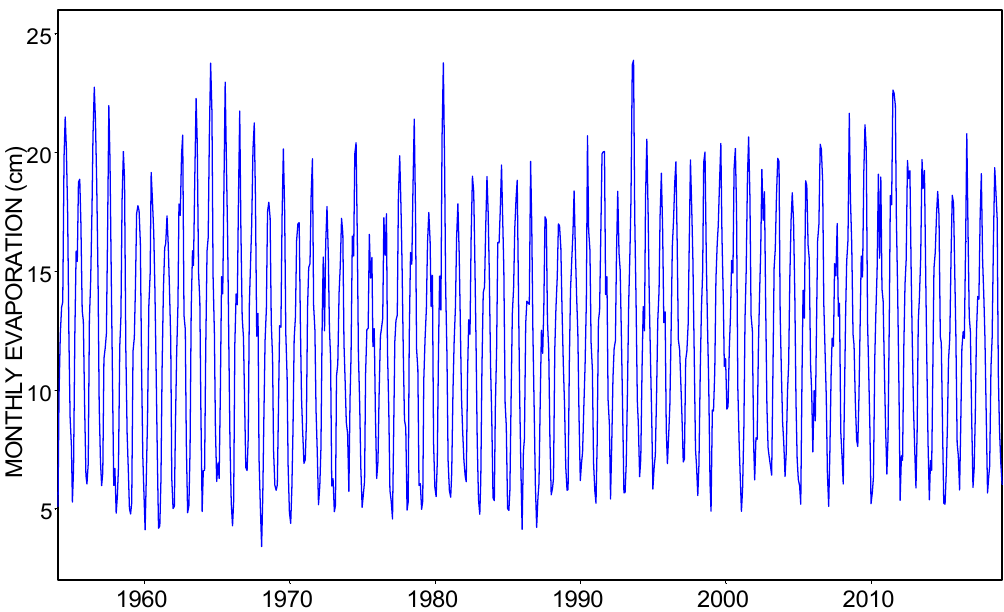
Figure 8. Statewide average monthly reservoir evaporation rates.